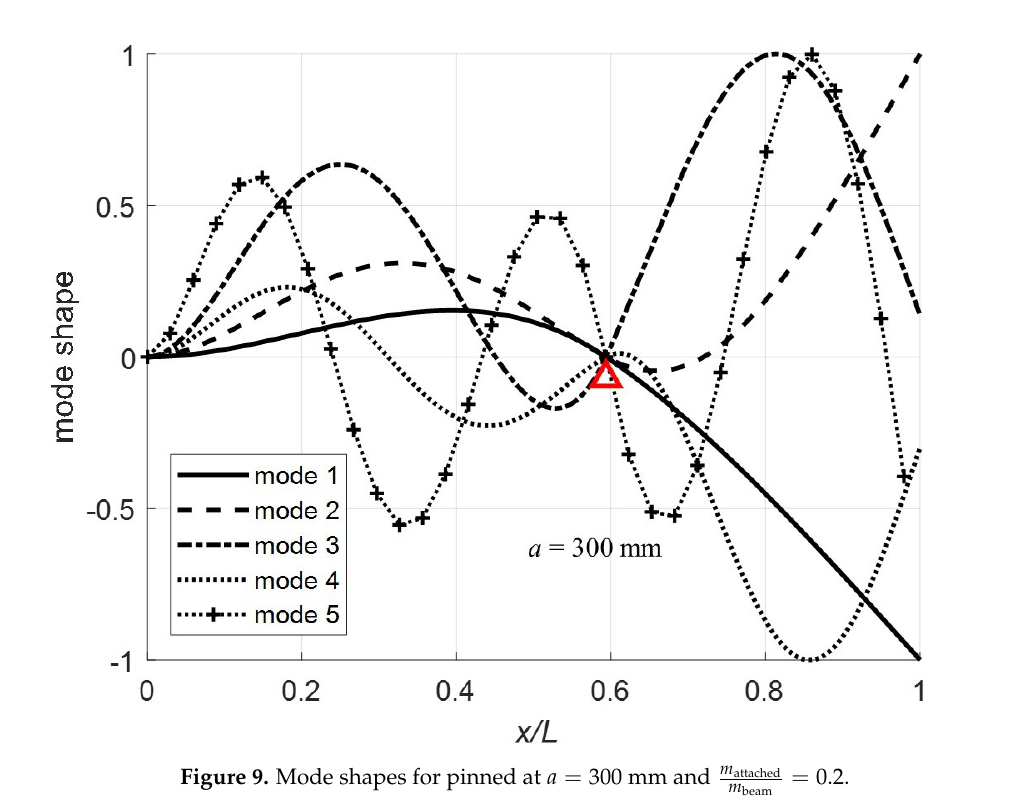
Figure 9. Mode shapes for pinned at a = 300 mm and m attached